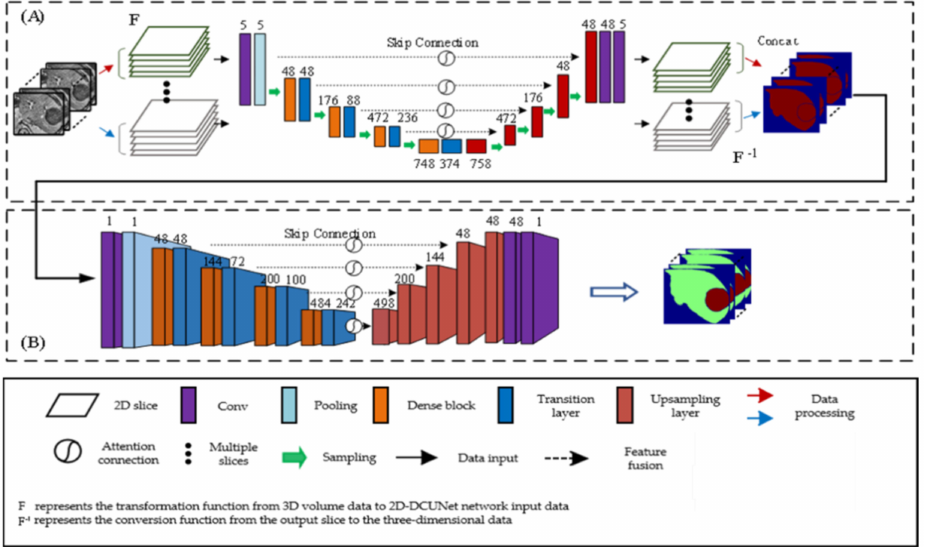
Figure 5. DCUNet-Tumor network structure diagram: ( A ) a two-dimensional U-Net network; ( B ) a three-dimensional U-Net